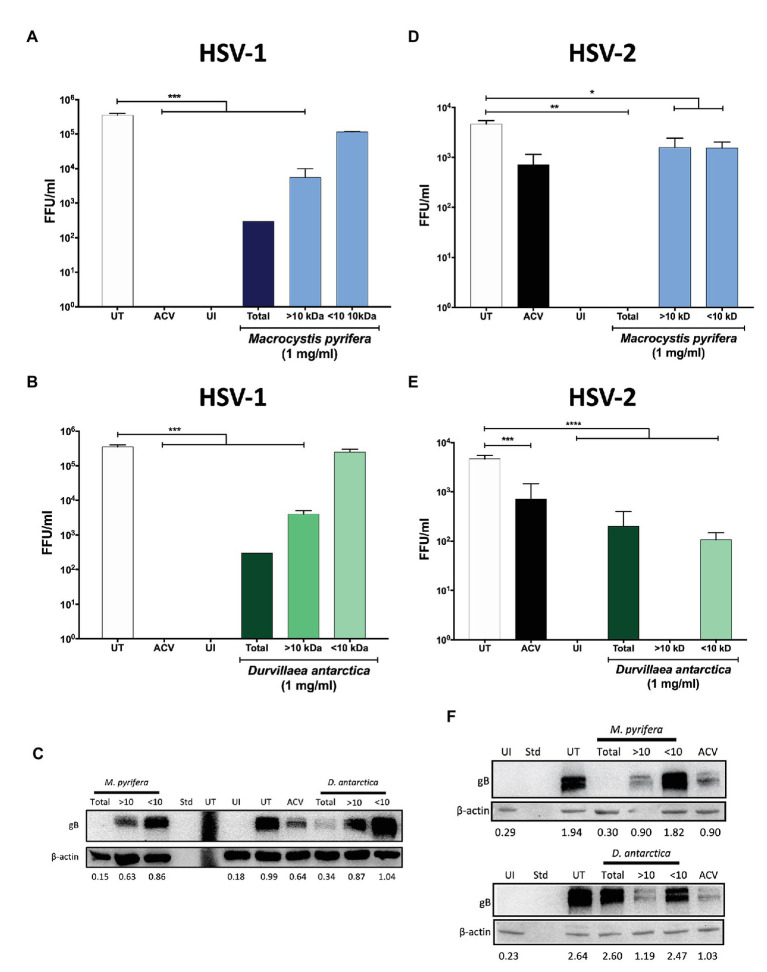
Antiviral activity in M. pyrifera and D. antarctica algae extracts fractionated by their size. The algae extracts were processed to separate >10 kDa or <10 kDa compounds. HeLa cells were infected with GFP-encoding HSV-1 or HSV-2 at an MOI 1 and then treated with 1 mg/ml of the >10 kDa algae fraction, <10 kDa algae fraction, or total extract. (A) Viral titers obtained from the supernatants of HSV-1-infected cells treated with the M. pyrifera extract for 24 h. (B) Viral titers obtained from the supernatants of HSV-1-infected cells treated with the D. antarctica extract 24 h. (C) Western blot analyses of the viral protein gB and the host protein beta-actin (loading control) 24 hpi with HSV-1 in cells treated with either antarctica for 24 h. (D) Viral titers obtained from the supernatants of HSV-2-infected cells treated with the M. pyrifera extract for 24 h. (E) Viral titers obtained from the supernatants of HSV-2-infected cells treated with the D. antartica extract for 24 h. (F) Western blot analyses of the viral protein gB and the host protein beta-actin (loading control) 24 hpi with HSV-2 in cells treated with either extract for 24 h. Representative images are shown for the western blots. Data shown are means ± SEM of three independent experiments. The data were analyzed using one-way ANOVA and Dunnett’s multiple comparisons tests. ****p < 0.0001; ***p < 0.001; **p < 0.01; and *p < 0.05. UI, uninfected cells; UT, untreated cells; ACV, acyclovir-treated cells; Std, standard.